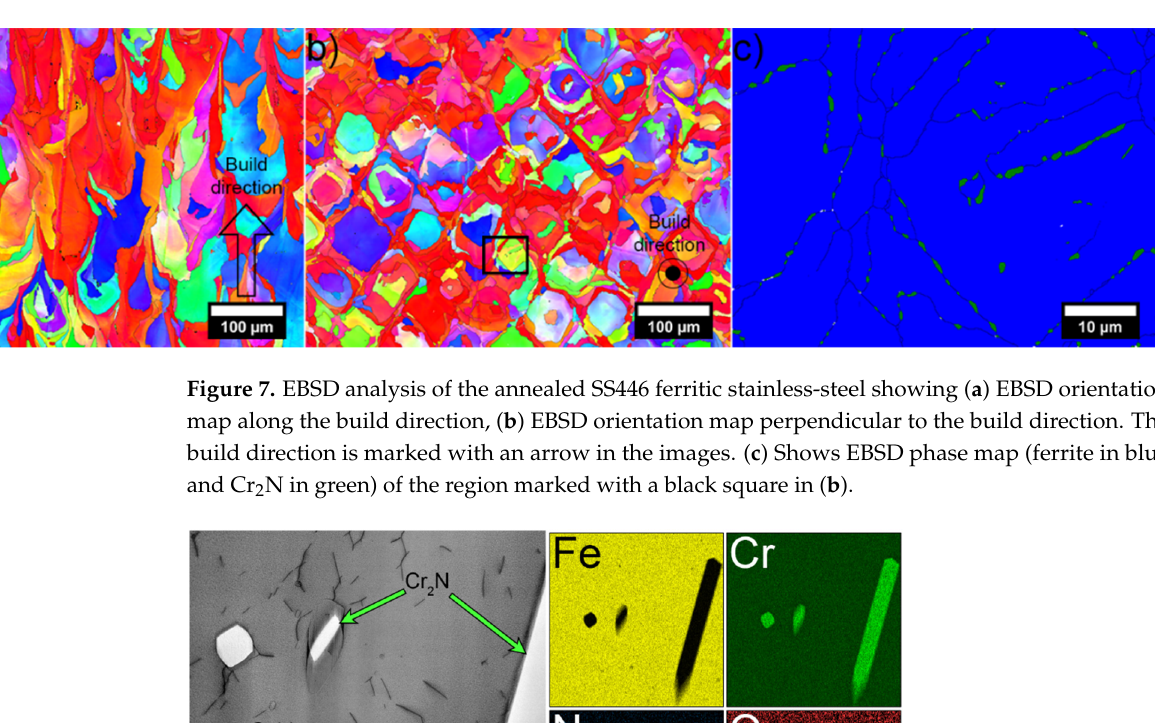
build direction is marked with an arrow in the images. ( c ) Shows EBSD phase map (ferrite in blue and Cr 2 N in green) of the region marked with a black square in ( b ).